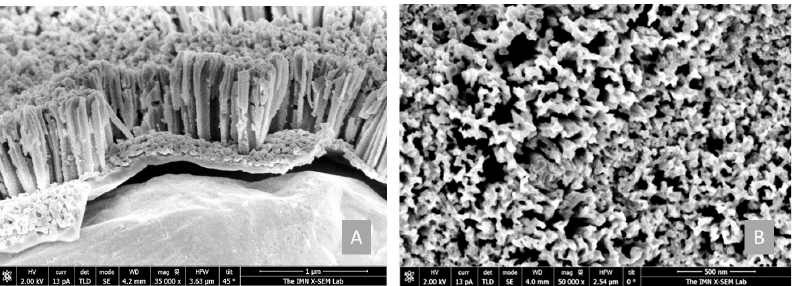
Figure 4. ( A ) Cross section and ( B ) top-view FESEM images of the a-SiNWs obtained after MACE. The a-Si:H(i) base material corresponds to a deposition at 200 ◦ C (see Table